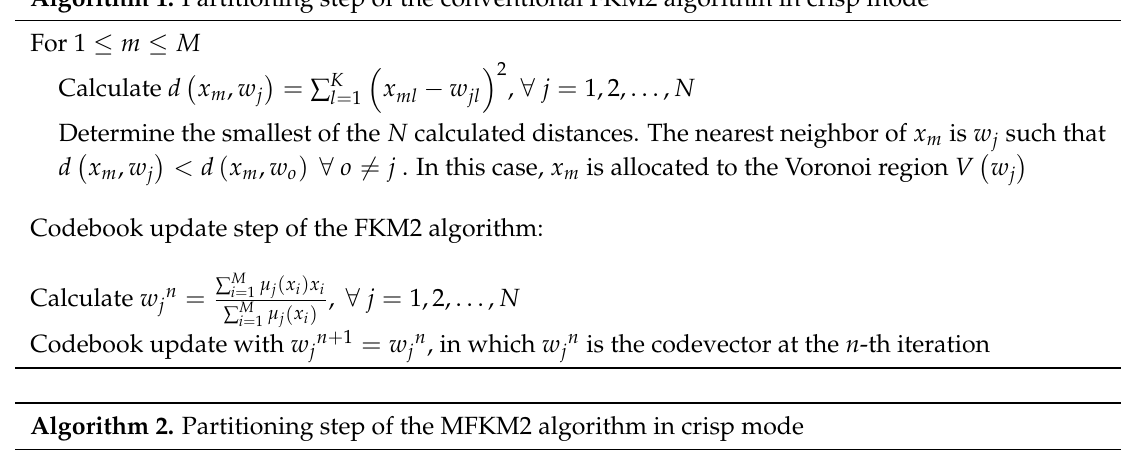
Algorithm 2. Partitioning step of the MFKM2 algorithm in crisp mode For 1 ≤ m ≤